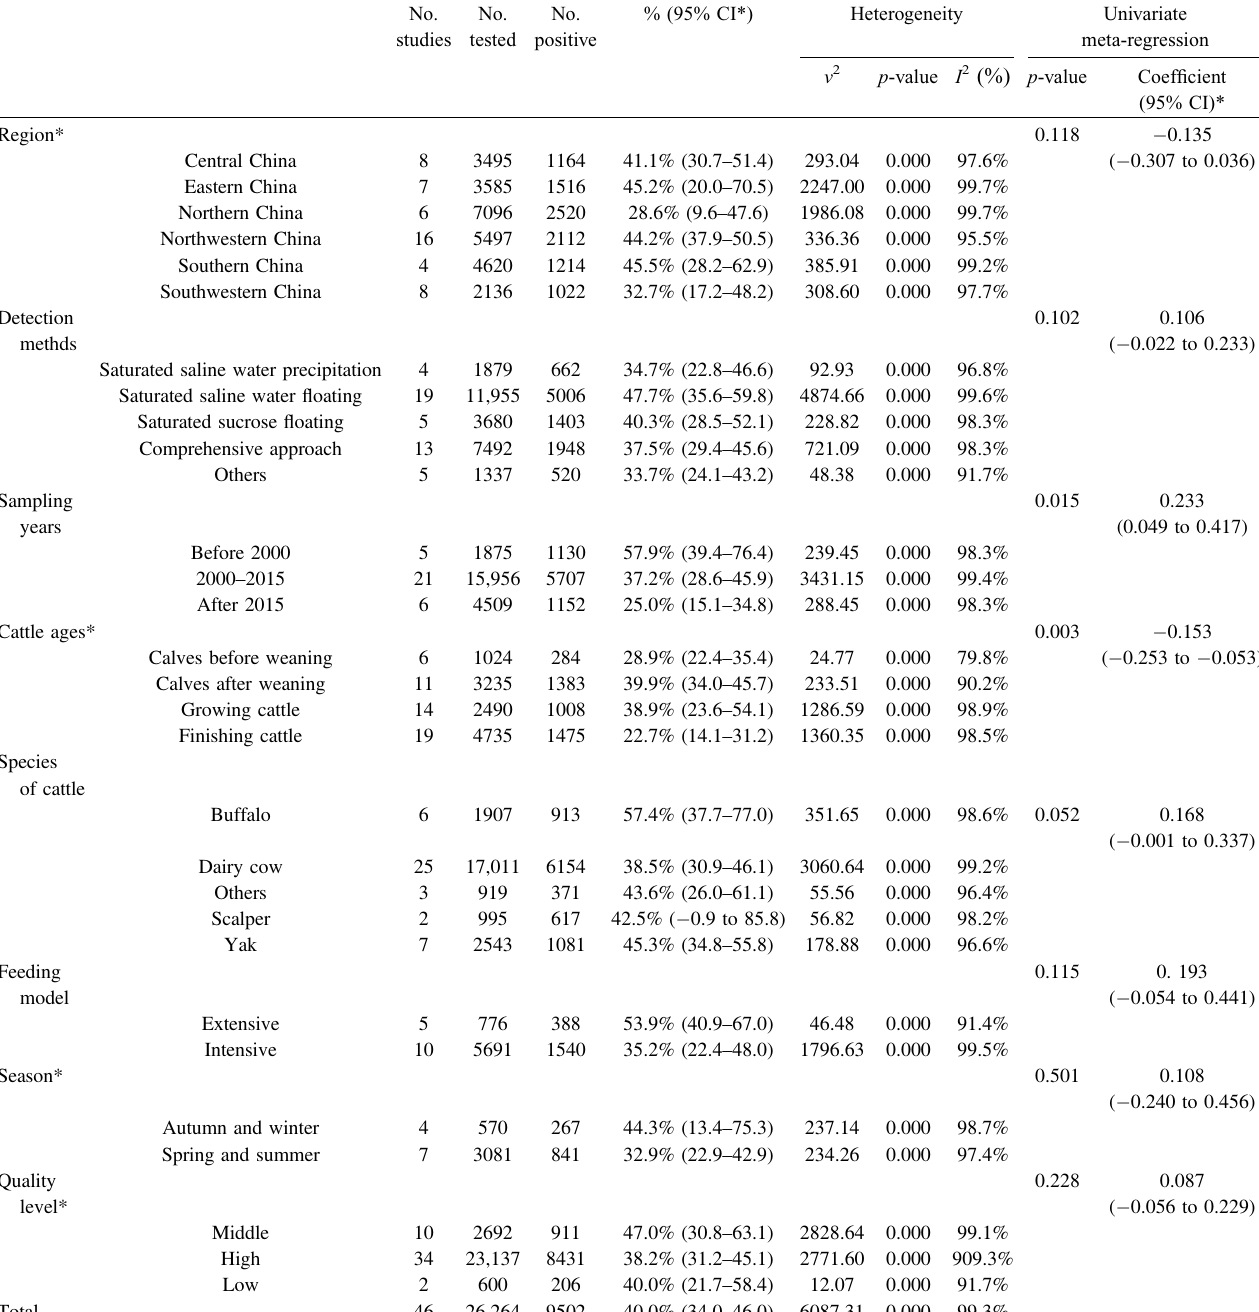
Table 2. Pooled prevalence of Eimeria in cattle in mainland